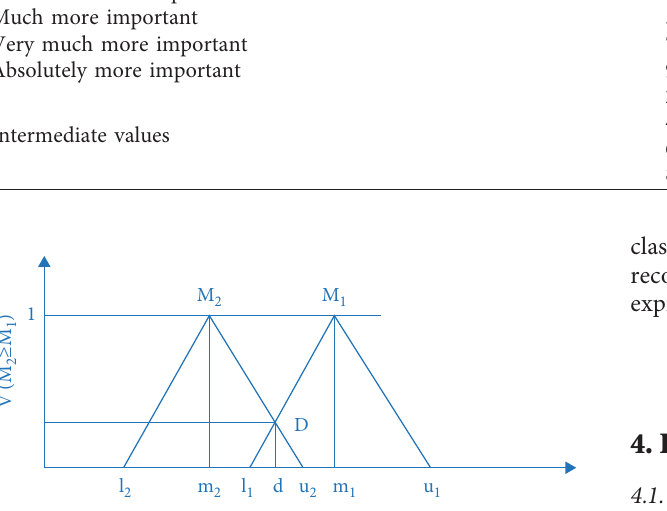
Figure 4: The degree of possibility